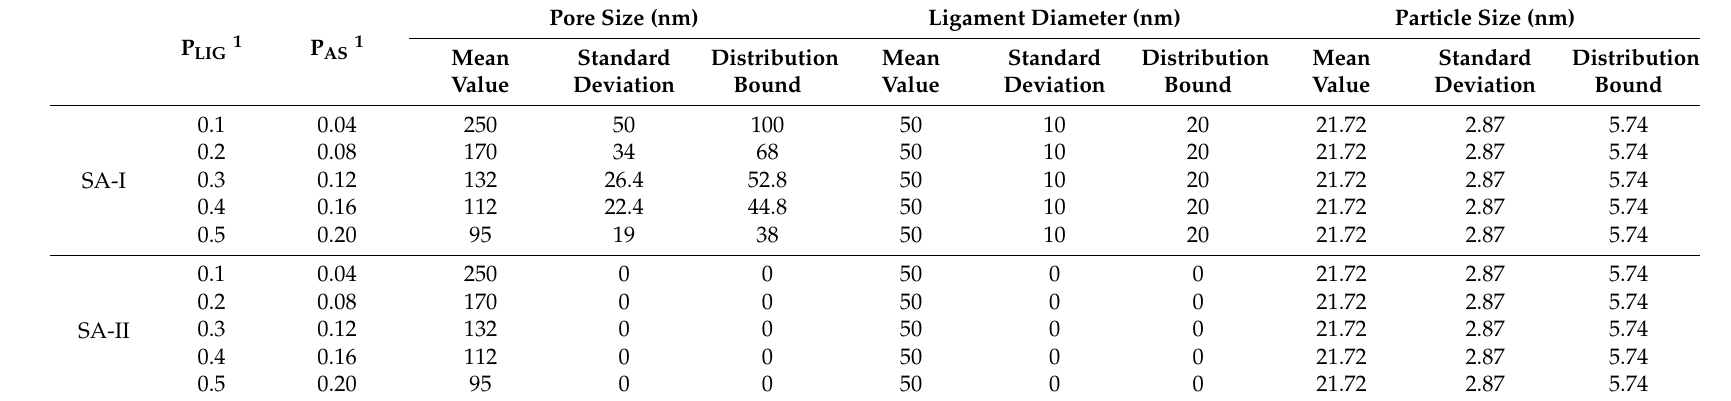
Table 1. Parameters used in the finite volume method